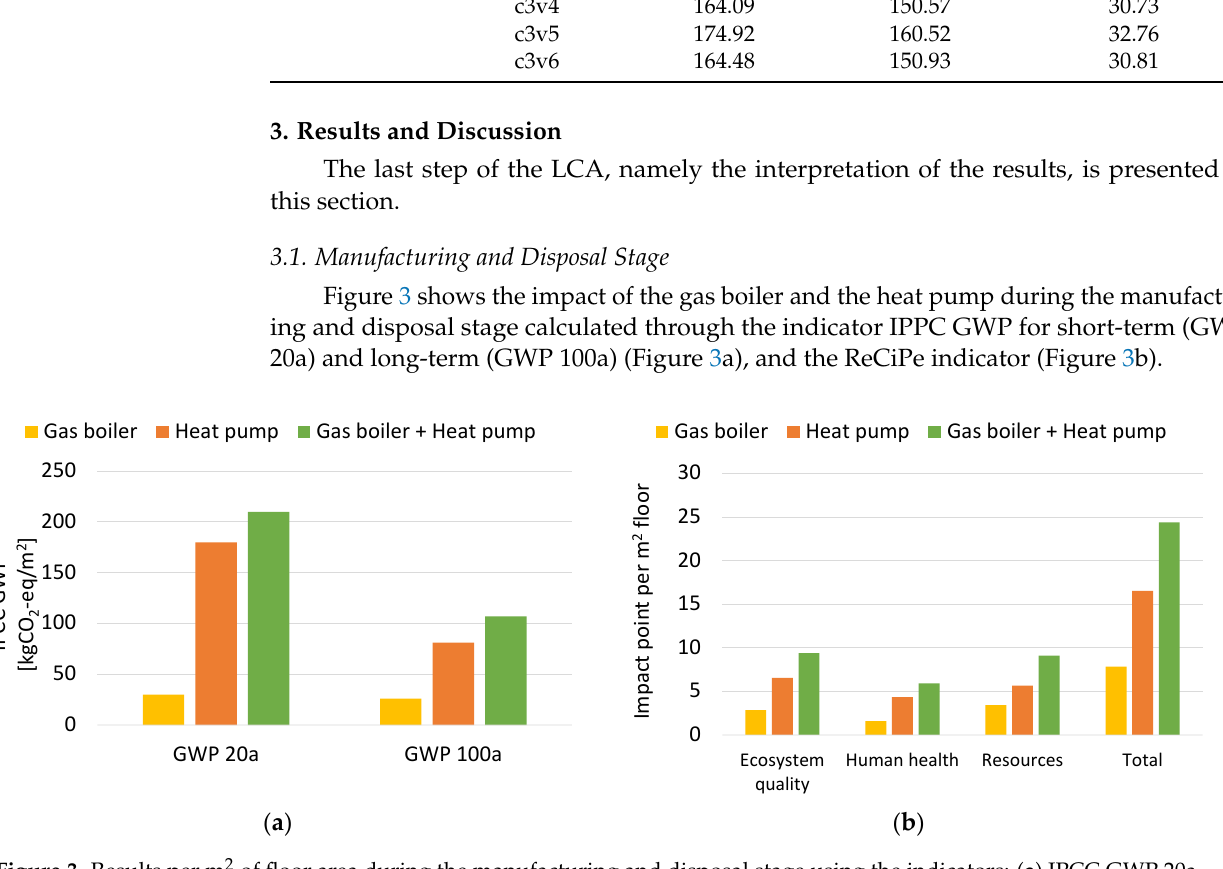
Figure 3. Results per m 2 of floor area during the manufacturing and disposal stage using the indicators: ( a ) IPCC GWP 20a and GWP 100a; and ( b ) ReCiPe.